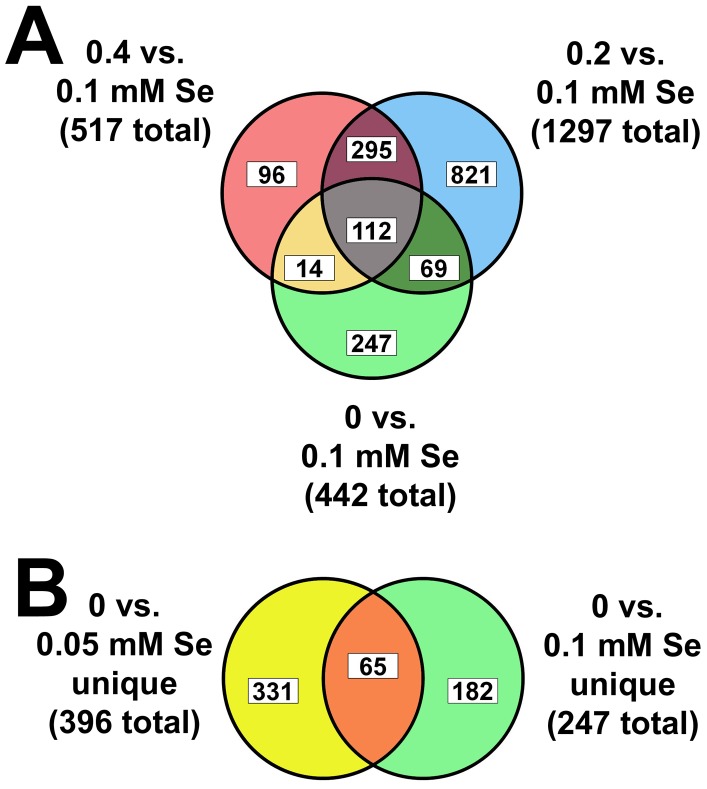
Identification of transcript datasets regulated by toxic Se and low Se.
A. Plotted is the overlap of transcript sets regulated ≥2-fold relative to 0.1 mM Se treatment for 0, 0.2 and 0.4 mM Se treatments (442, 1297, 517 total transcripts in each set, respectively). The 295 overlapping transcripts for toxic Se (0.2 and 0.4 mM), and the 247 transcripts unique to low Se (0 mM vs 0.1 mM Se), were analyzed further for toxic Se and low Se changes. B. Plotted is the overlap of the 247 transcripts unique to low Se (0 mM) when compared to 0.1 mM Se (shown in A), and the 396 transcripts unique to low Se (0 mM) when compared to 0.05 mM Se, resulting in the “low Se specific” dataset of 65 transcripts changed ≥2-fold by 0 mM Se relative to both 0.05 and 0.1 mM Se.